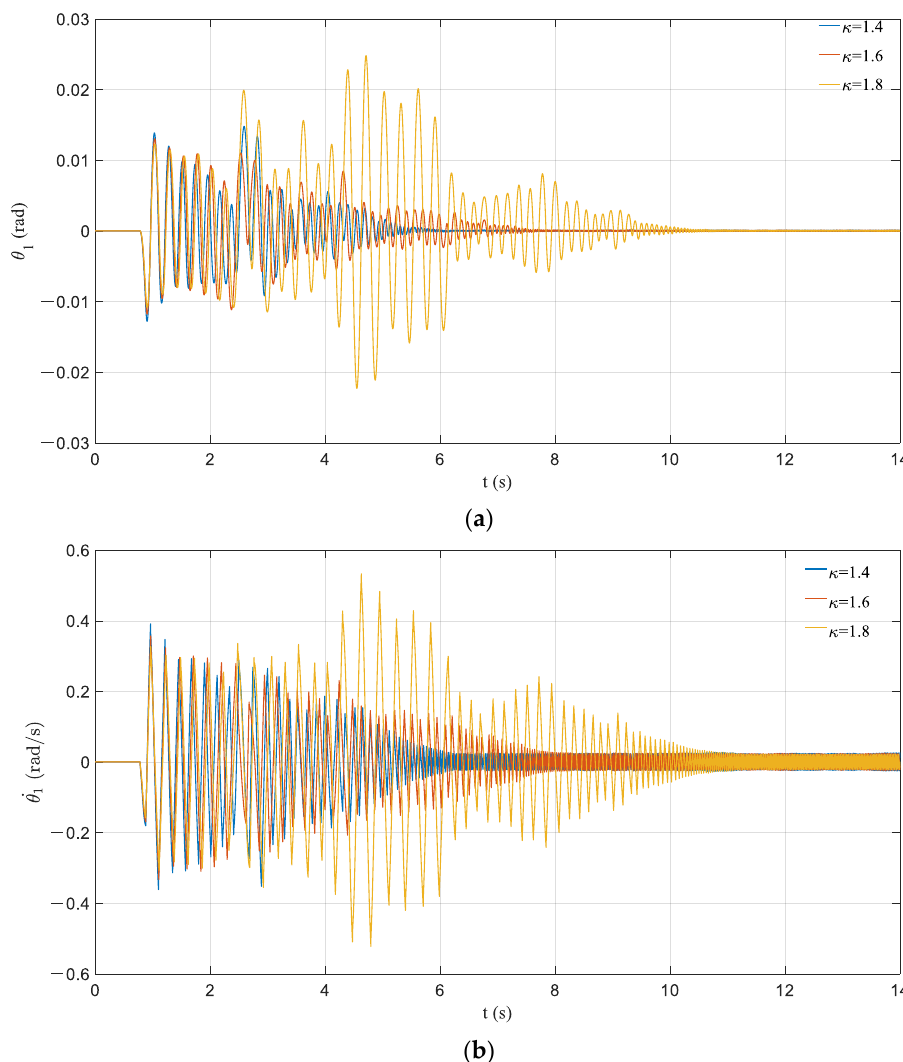
 : ( a ) time history of rocking rotation; ( b ) time history of angular velocity.